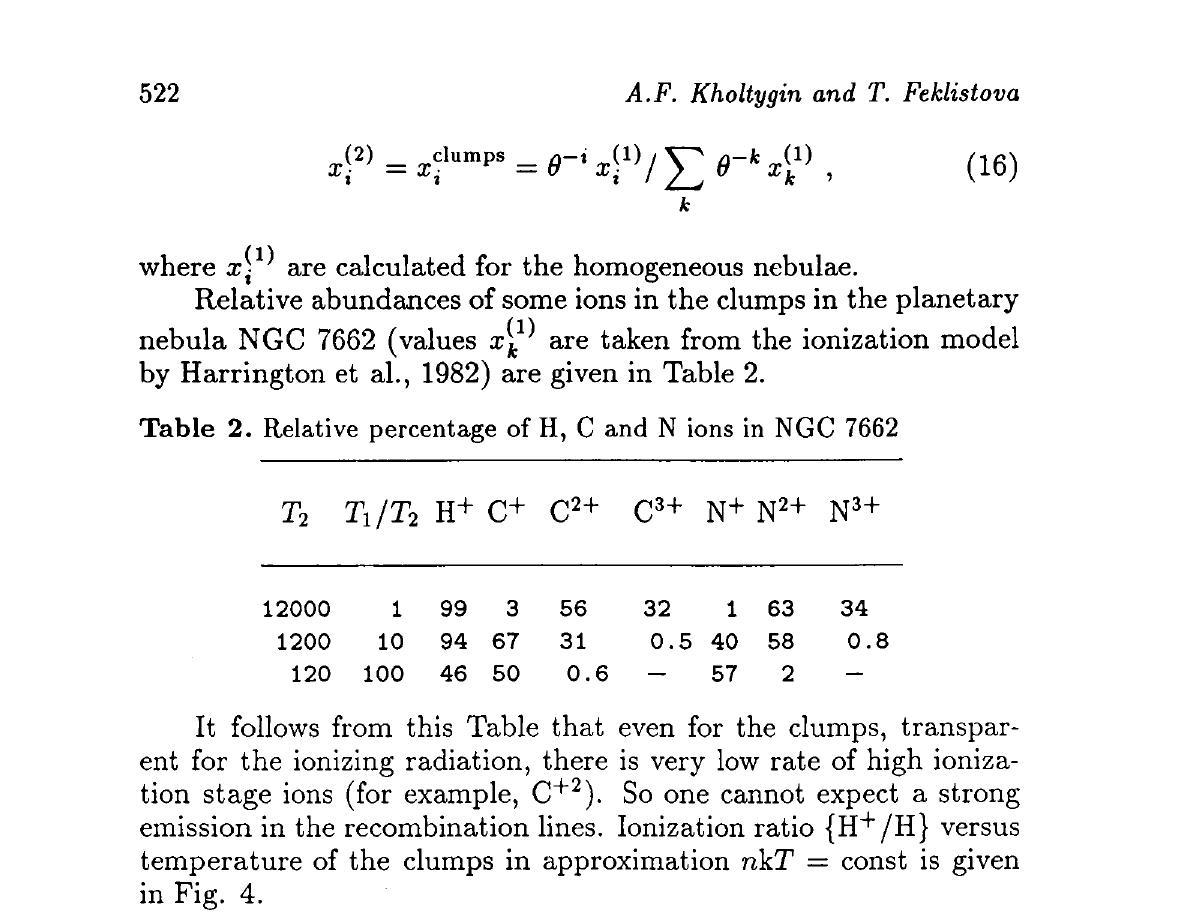
Table 2. Relative percentage of H, C and N ions in NGC